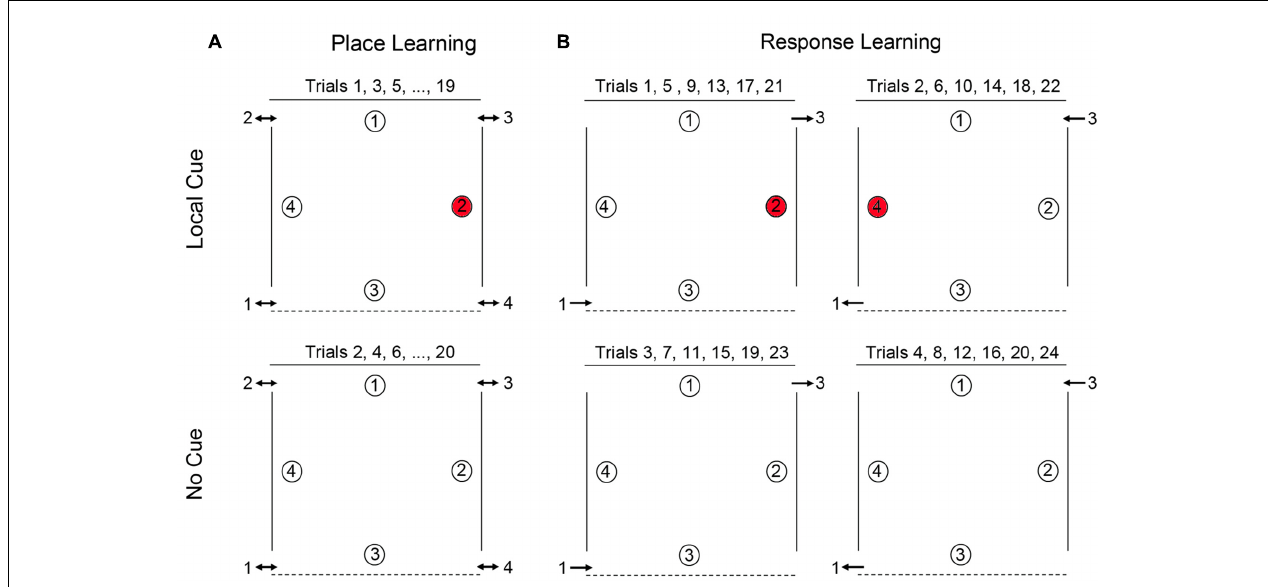
FIGURE 1 | Schematic representation of the open-field arena used for testing place learning (A) and response learning (B) . For place learning, the reward was always placed at the same location within the arena (location 2 for 50% of the participants and location 4 for the other 50% of the participants). For response learning, the reward (at either location 2 or location 4 on alternate trials) could be found by performing the same motor response upon entering the